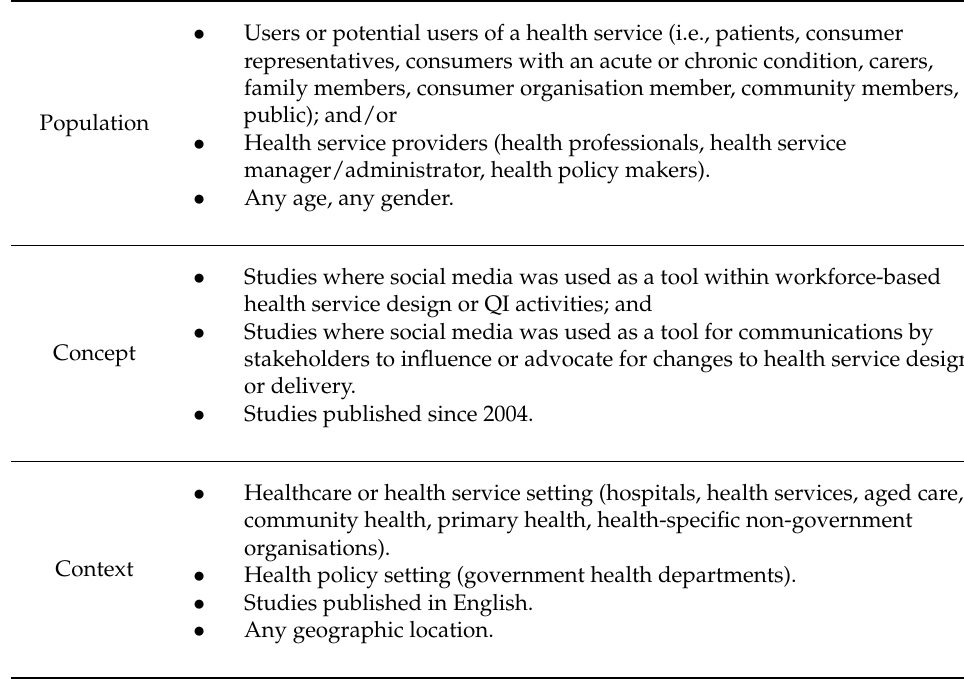
Table 1. Scoping review eligibility